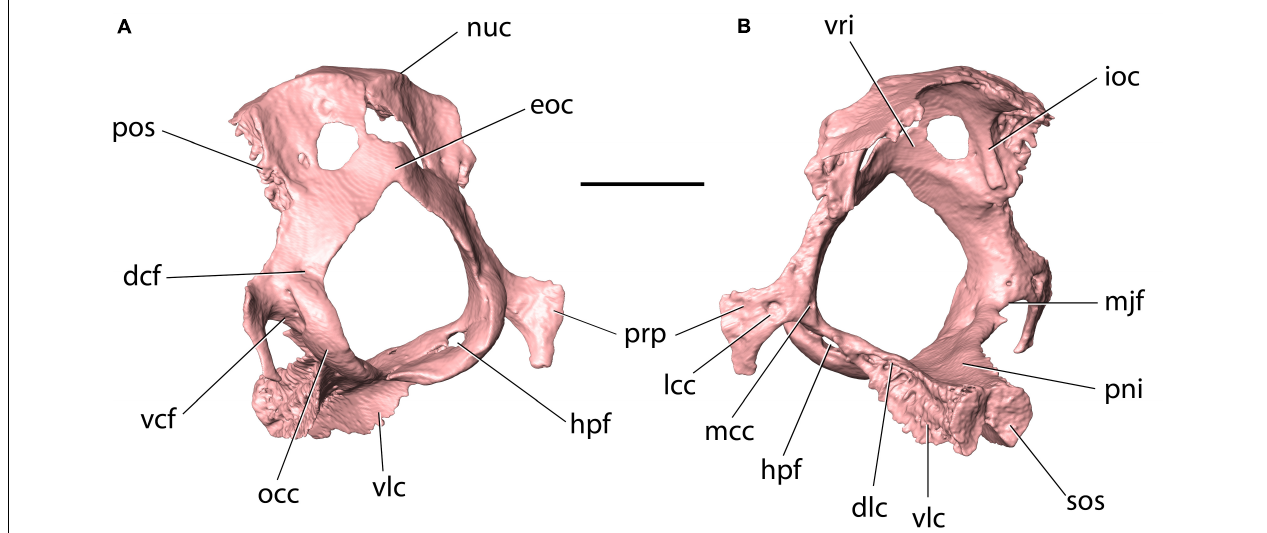
FIGURE 11 | Occipital of Palaeolagus haydeni (FMNH PM9476) in (A) posteroventrolateral and (B) anterodorsolateral views. Note the ventral condyloid fossa perforated by two foramina. dcf, dorsal condyloid fossa; dlc, dorsolateral crest; eoc, external occipital crest; hpf, hypoglossal foramen; ioc, intraoccipital crest; lcc, lateral opening of condyloid canal; mcc, medial opening of condyloid canal; mjf, posteromedial margin of jugular foramen; nuc, nuchal crest; occ, occipital condyle; pni, pontine impression; pos, petrosooccipital suture; prp, paracondylar process; sos, sphenooccipital synchondrosis; vcf, ventral condyloid fossa; vlc, ventrolateral crest; vri, vermiform impression. Scale bar = 5